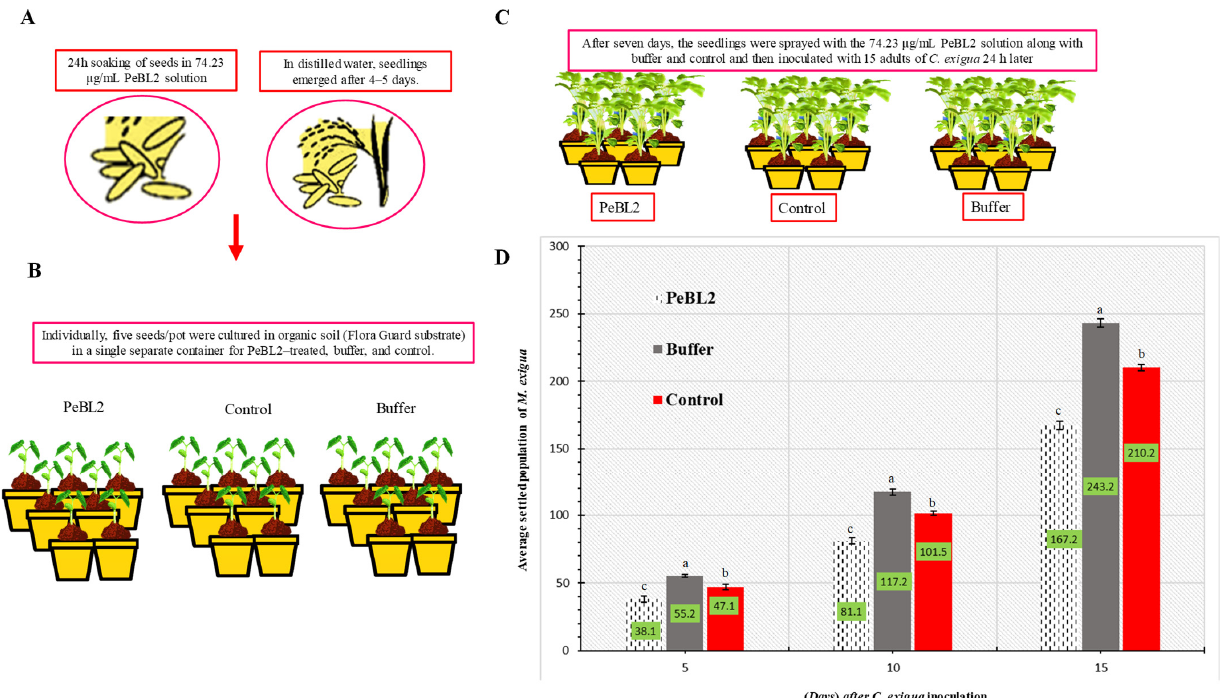
Figure 2. Plants treated with PeBL2, control, and buffer showed C. exigua population variations.